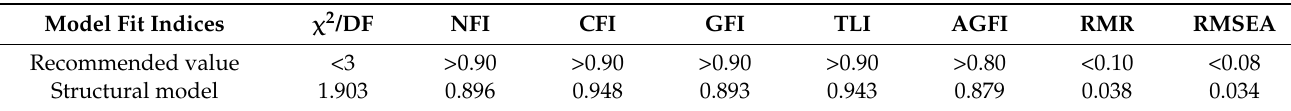
Table 6. The recommended values and actual values of fit